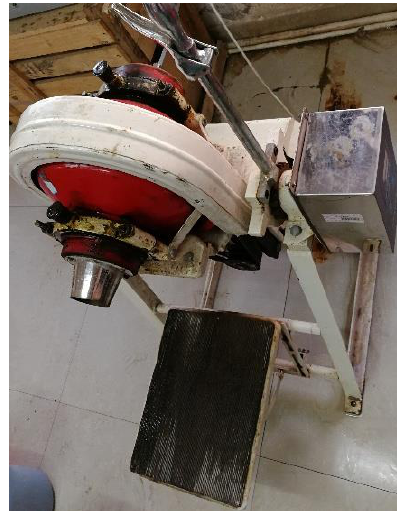
Figure 2. Conical ball mill.